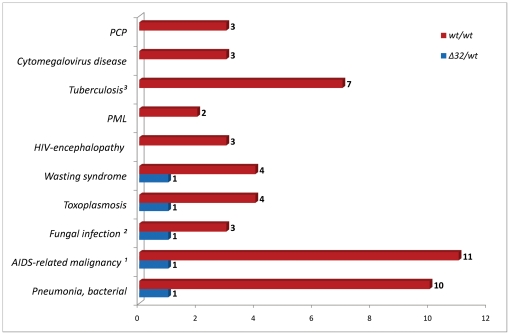
Causes of AIDS-related deaths and CCR5 wt/wt vs. CCR5 Δ32/wt genotype.
1 AIDS-related malignancy: B-cell lymphoma (n = 4), Burkitt lymphoma (n = 1), immunoblastic lymphoma (n = 1), primary CNS lymphoma (n = 4), non-Hodgkin lymphoma - unspecified location (n = 2); 2 Fungal infection: pulmonary candidosis (n = 2), generalised cryptococcosis (n = 1); 3 Tuberculosis: pulmonary (n = 4), tuberculotic sepsis (n = 3).